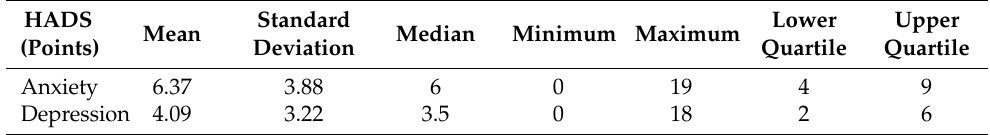
Table 3. Statistical characteristics of the intensity of anxiety and depression in the respondents.